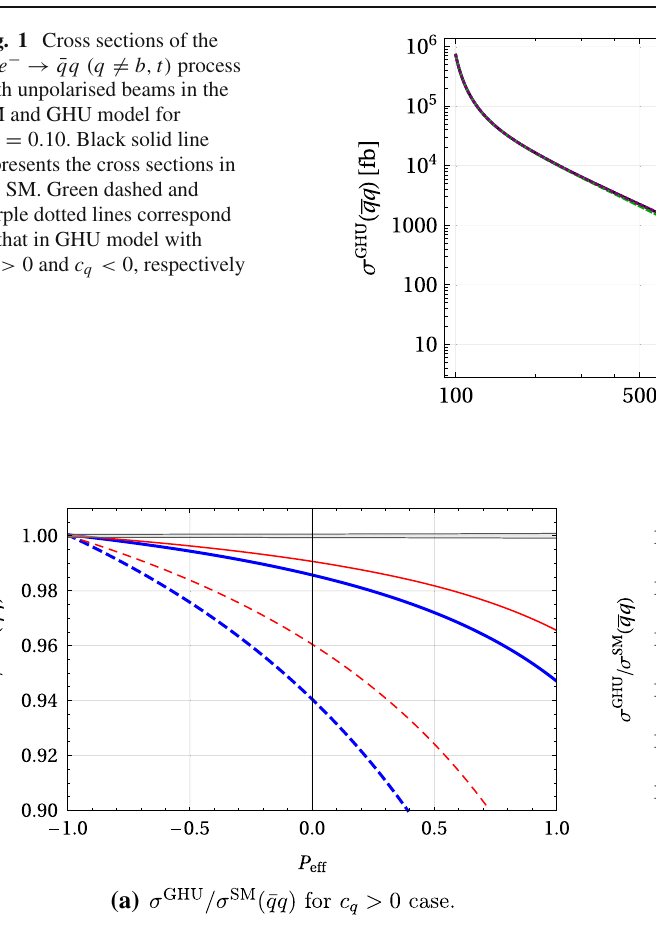
Fig. 2 Ratio of the cross sections in the GHU model to that in the respectively. Blue-thick and red-thin lines correspond to θ H = 0 . 10 and SM with polarisation beams for the e + e − → ¯ qq ( q (cid:14)= b , t ) process. 0 . 08, respectively. The gray band indicates the statistical uncertainty at √ s = 250 GeV with 250 fb − 1 The left figure shows the c q > 0 case and the right figure shows the √ c q < 0case.Solidanddottedlinesarefor s = 250 GeVand500 GeV,